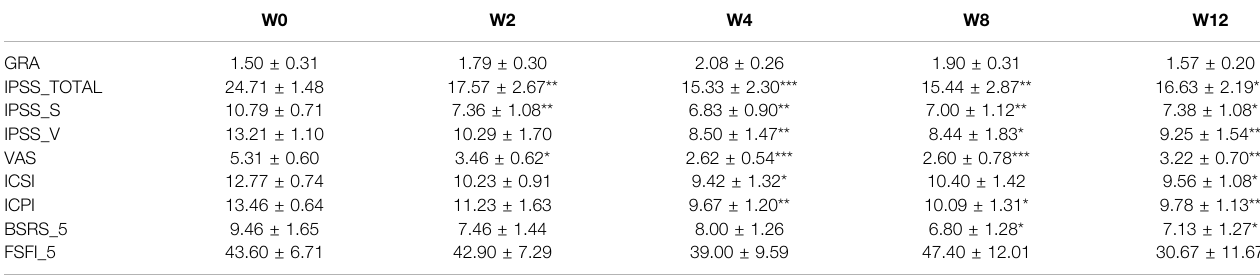
TABLE 3 | Summary of Global Response Assessment (GRA), International Prostate Symptom Score (IPSS-TOTAL), IPSS-voiding (IPSS-V), IPSS-storage (IPSS-S), visual analogscale(VAS),O ’ Leary-SantInterstitialCystitisSymptomIndex(ICSI)andInterstitialCystitisProblemIndex(ICPI),5-itemBriefSymptomRatingScale(BSRS-5),and 5-item Female Sexual Function Index (FSFI-5) questionnaires assessment.